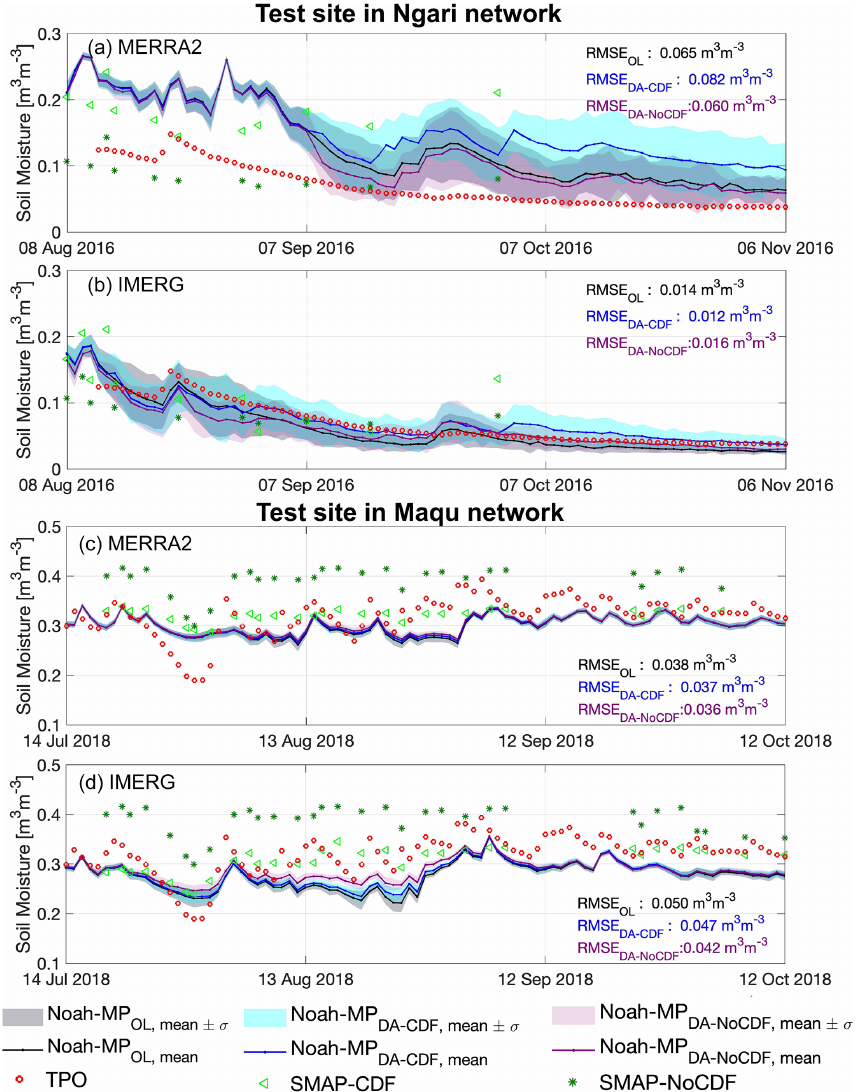
Figure 3. Comparative time series of open loop (OL)- and data assimilation (DA)-estimated surface (top 5cm) soil moisture. The solid line represents the ensemble mean, whereas the shaded areas represent ± 1 standard deviation ( σ ) across the full ensemble. DA-CDF is assimilation with CDF matching, DA-NoCDF is assimilation without CDF matching, TPO is the Tibetan Plateau Observatory measurements, SMAP-CDF is the SMAP retrieval value after CDF matching, and SMAP-NoCDF is the original SMAP retrieval